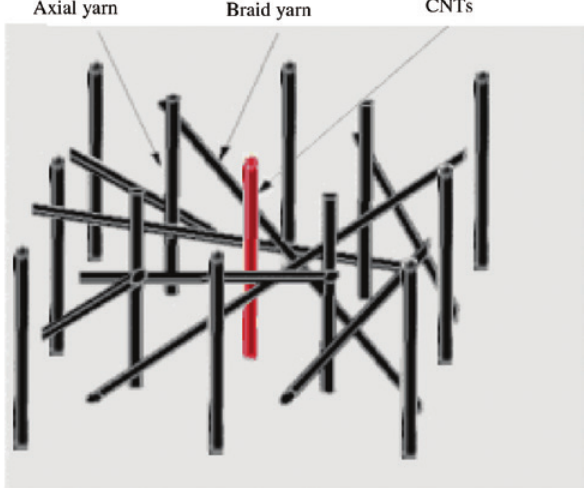
Figure 2: Space structure of carbon nanotube threads (CNTs) embedded into composites in 3-D five